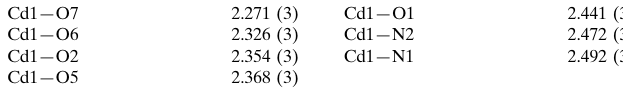
Selected geometric parameters (A˚ , (cid:3)